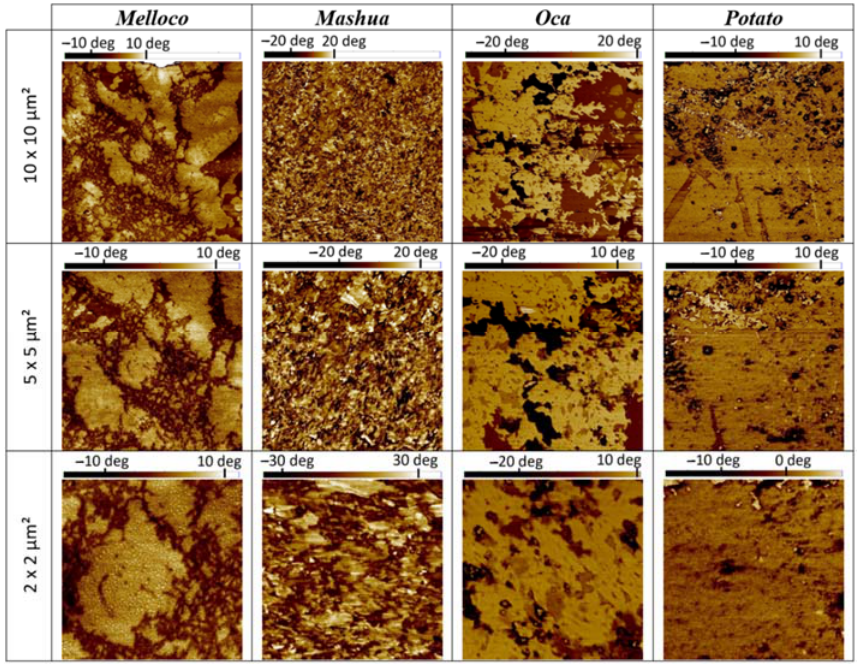
Figure 7. Phase contrast ( tapping mode) images measured on films extracted from each Andean tuber analyzed at different spans.